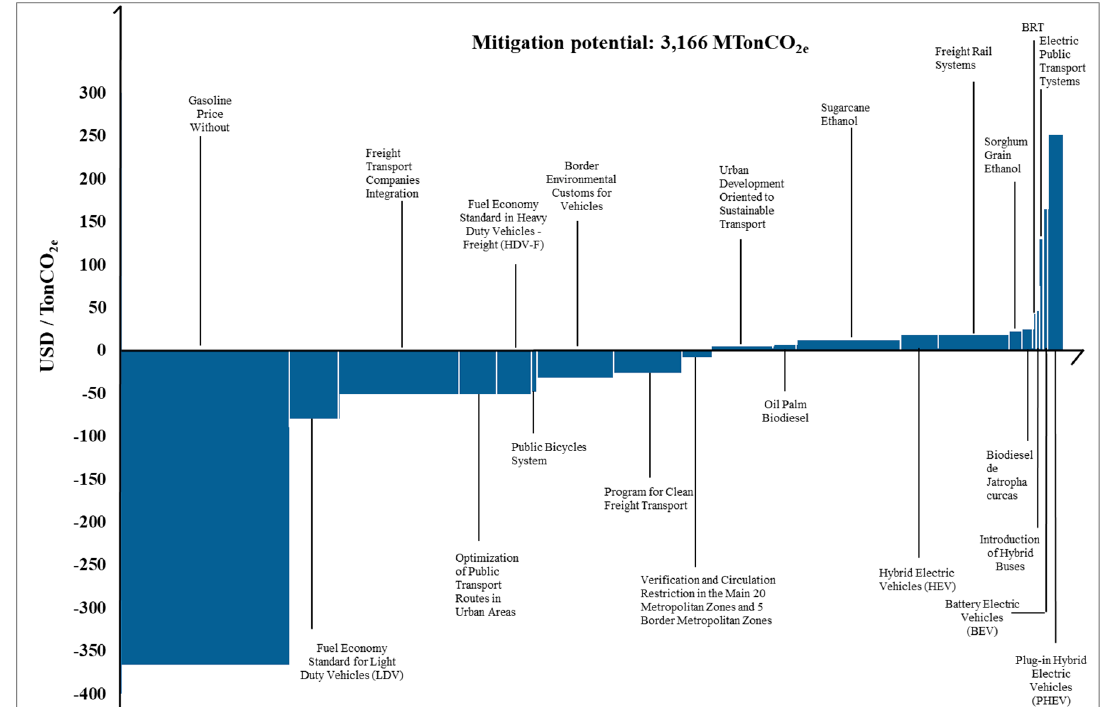
Figure 8. Marginal abatement cost curve for transport sector in Mexico.